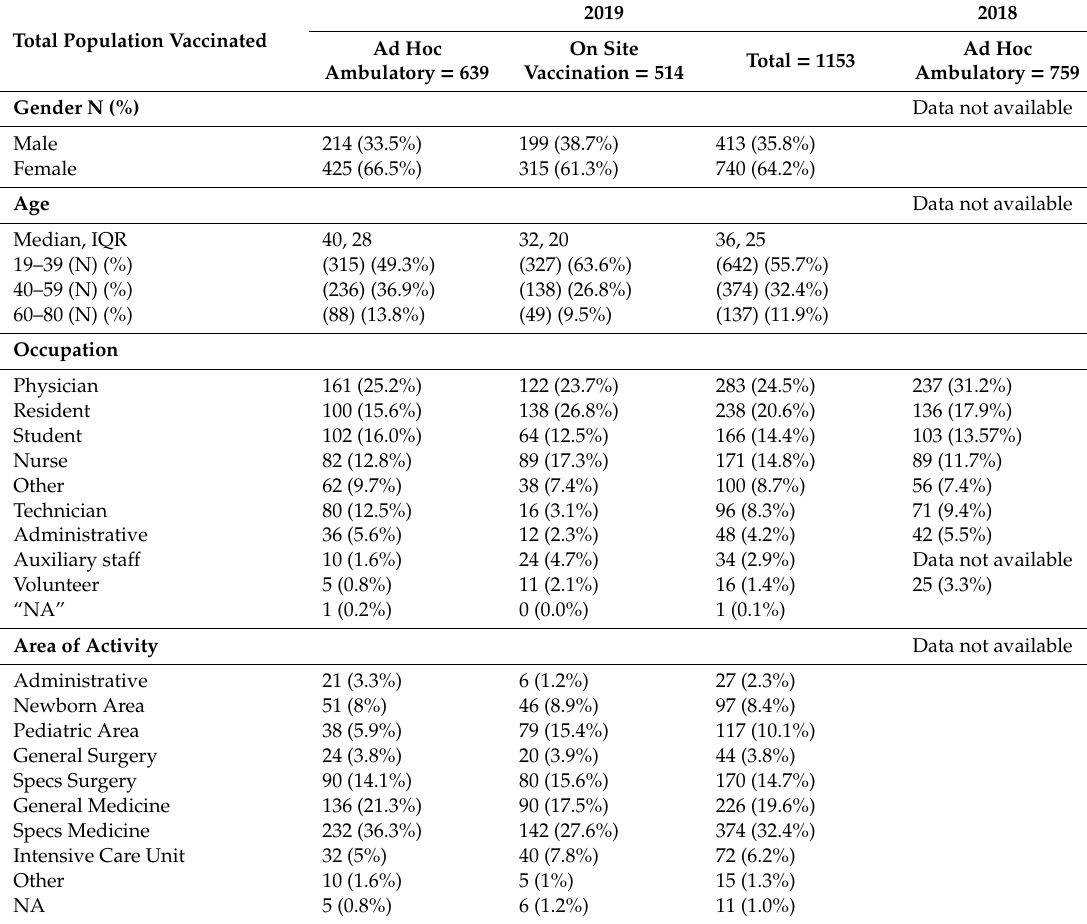
Table 2. Data about vaccinated people out of the total vaccinated (year